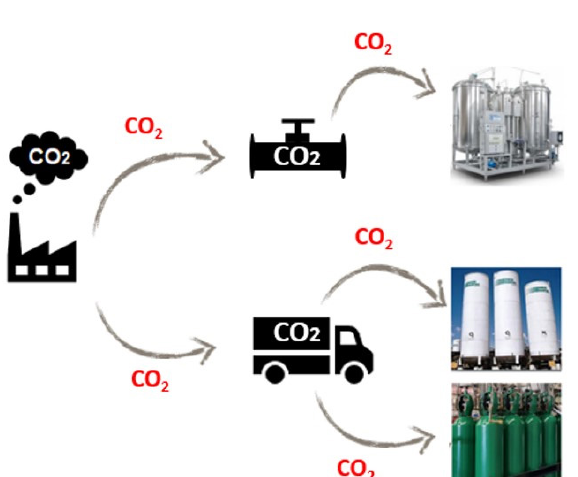
Figure 1. Transporting CO 2 to serve the industry that captured it and other customers (adapted from